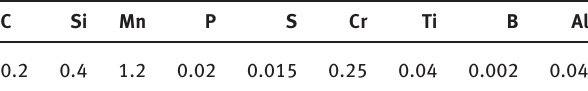
Table 1: Chemical compositions of BR1500HS